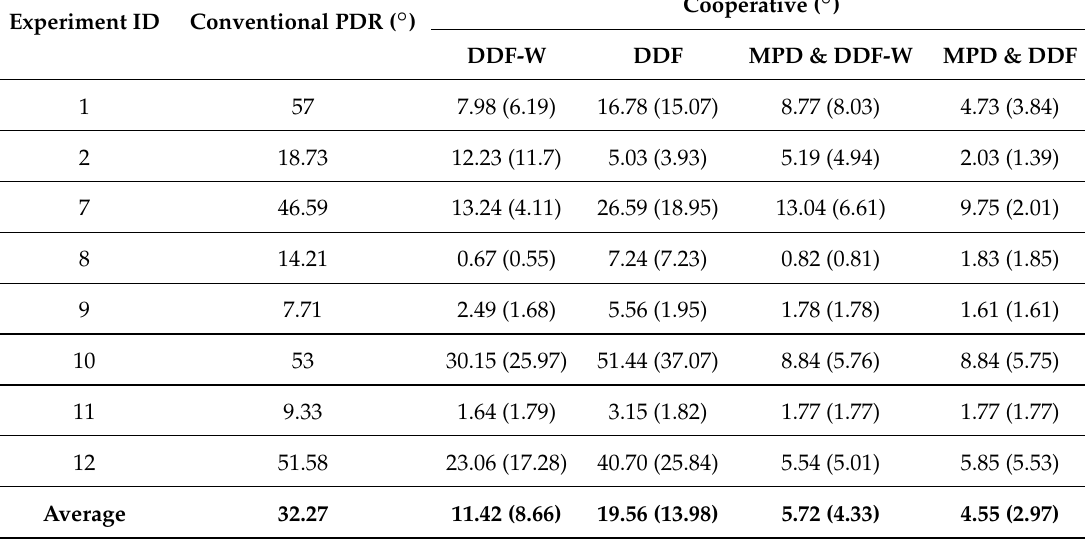
Table 5. Heading errors in degree. Data in parenthesis represent outcomes obtained by PC performing with 100%